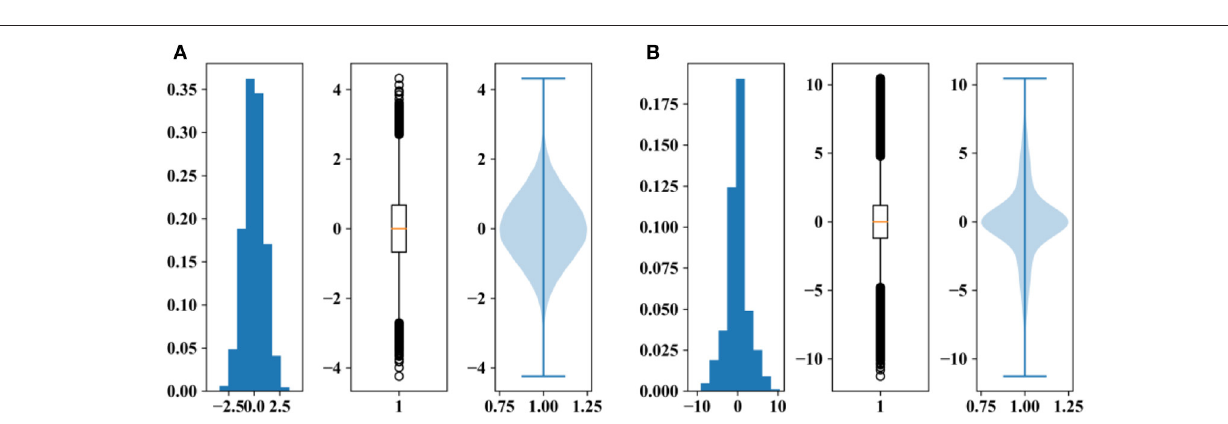
FIGURE 10 | Distributions of the standardized MK statistics with different autocorrelation coefficients. (A) Autocorrelation coefficient coefficient =